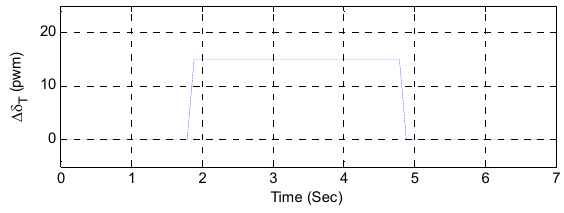
Figure 4. Thrust pulse with time step of 3 s as input.